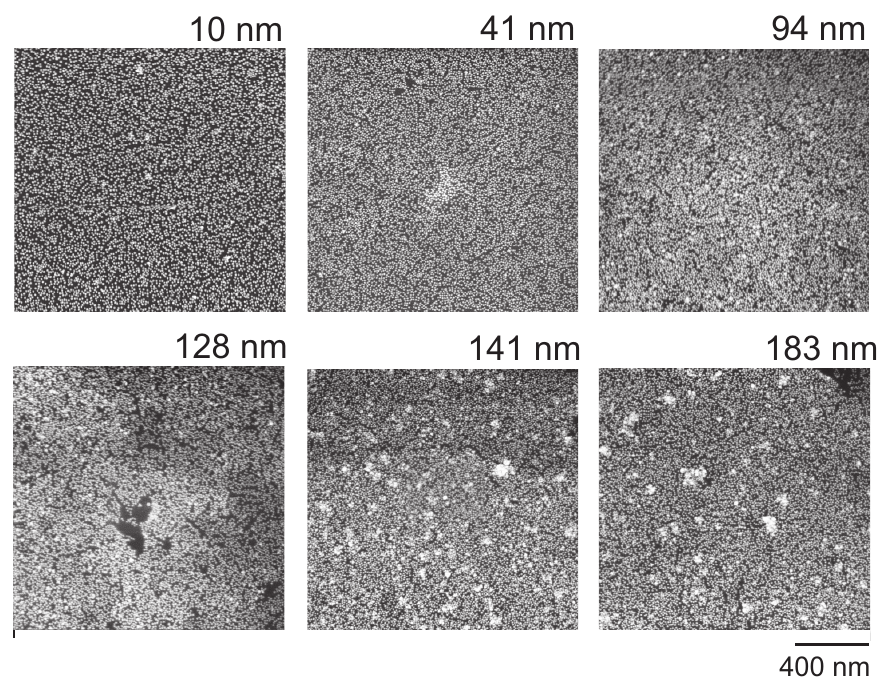
Figure 5. SEM images of PDMAEMA/AuNP-13 hybrids with different thickness. Images were recorded in top view.